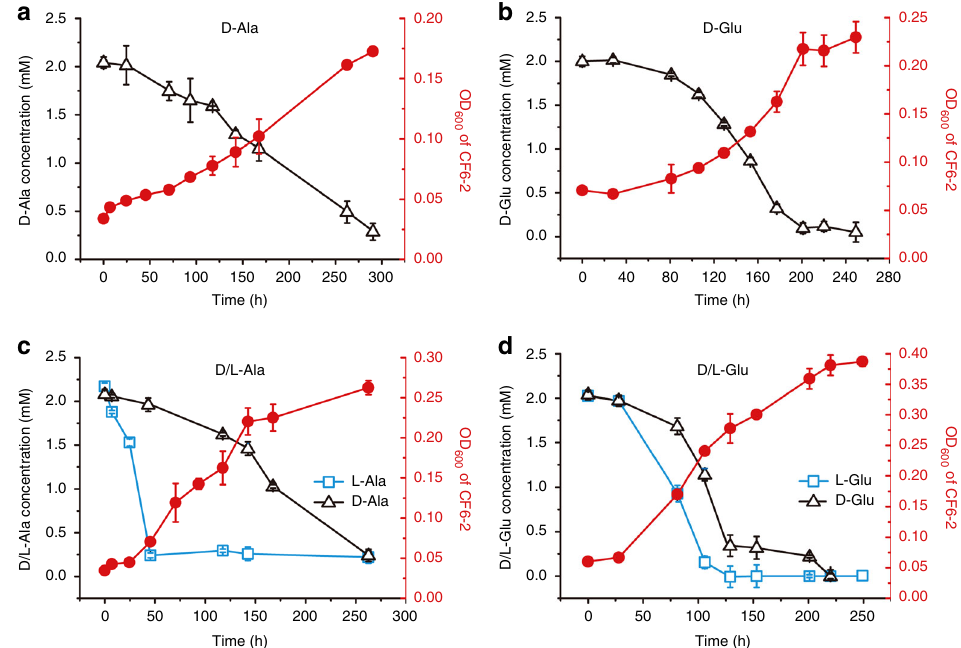
Fig. 7 Utilization of D -Ala and D -Glu by strain CF6-2. a Growth curve of strain CF6-2 cultured in the medium containing 2 mM D -Ala. b Growth curve of strain CF6-2 cultured in the medium containing 2 mM D -Glu. c Growth curve of strain CF6-2 cultured in the medium containing 2 mM D -Ala and 2 mM L -Ala. d Growth curve of strain CF6-2 cultured in the medium containing 2 mM D -Glu and 2 mM L -Glu. The red line shows the optical density of bacterial culture measured at 600 nm and the black and blue lines indicate the concentrations of D -amino acid and L -amino acids, respectively, in the media over time. The error bars represent standard deviations from triplicate experiments. Source data are provided as a Source Data fi